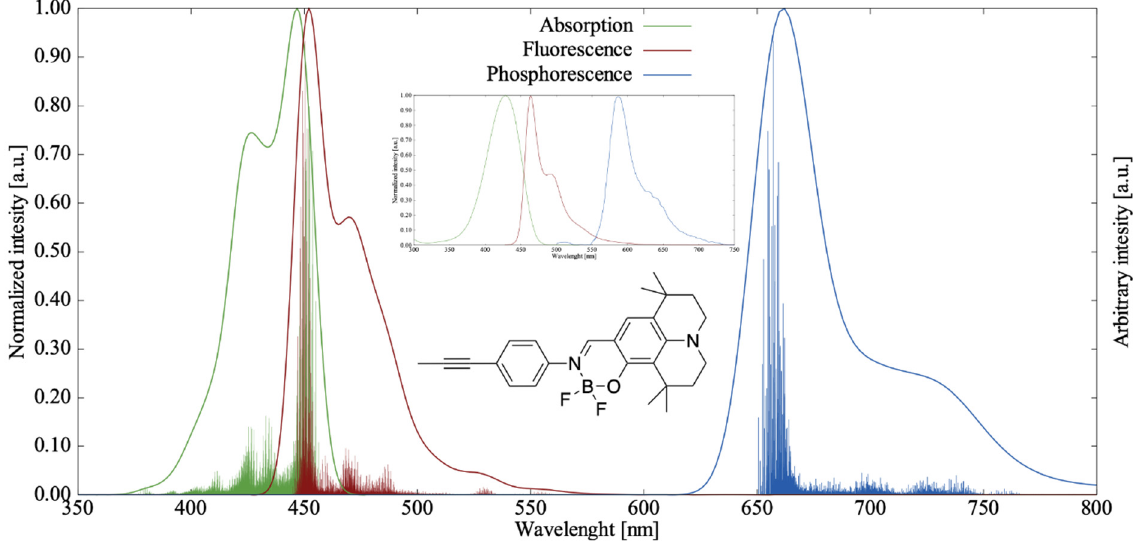
Figure 9. Computed vibronic spectra of the displayed boranil. The green, red, and blue curves represent the absorption, fluorescence, and phosphorescence spectra simulated in the basis of the individual vibronic peaks (sticks). The inset is the experimental measurement taken from Reference [39]. Adapted from Reference [61] with permission from the PCCP Owner Societies.